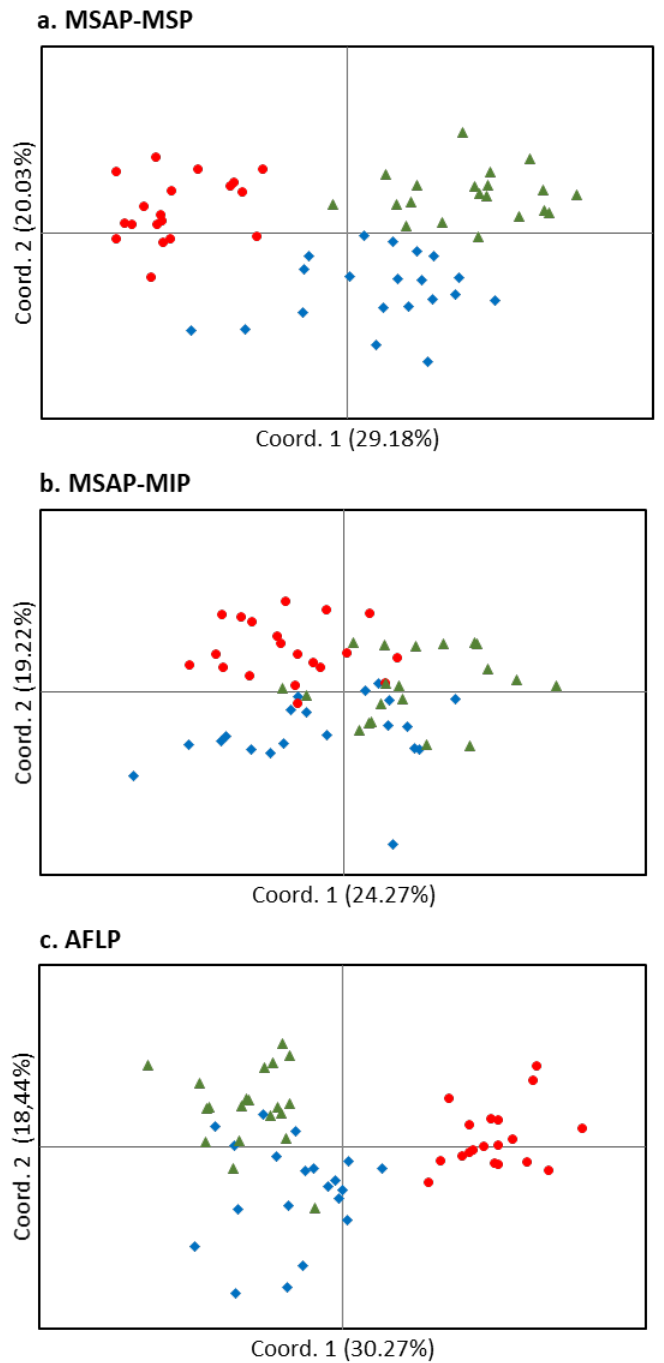
Figure 1. Principal Component Analyses (PCoA) of German (blue diamond), Spanish (red circles) and Swedish (green triangles) provenances based on MSAP-MSP ( a ), MSAP-MIP ( b ) or AFLP ( c ). The explained variance percentages for each coordinate are shown in brackets.